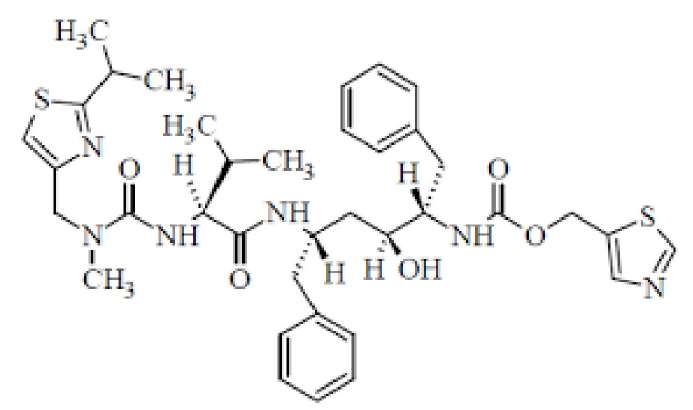
Figure 13. Structure of PAXLOVID™.